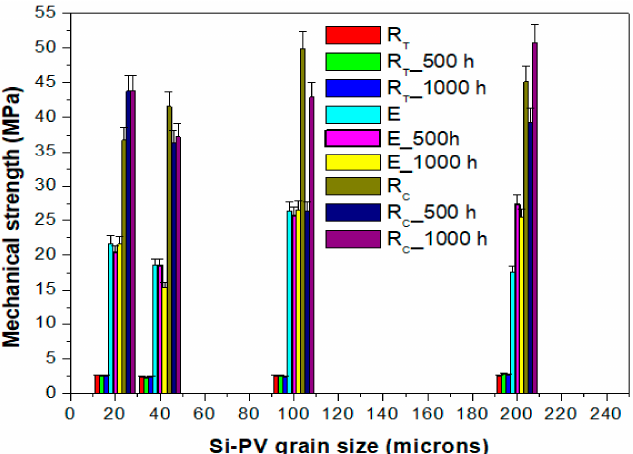
Figure 3. Water immersed samples (500 and 1000 h).